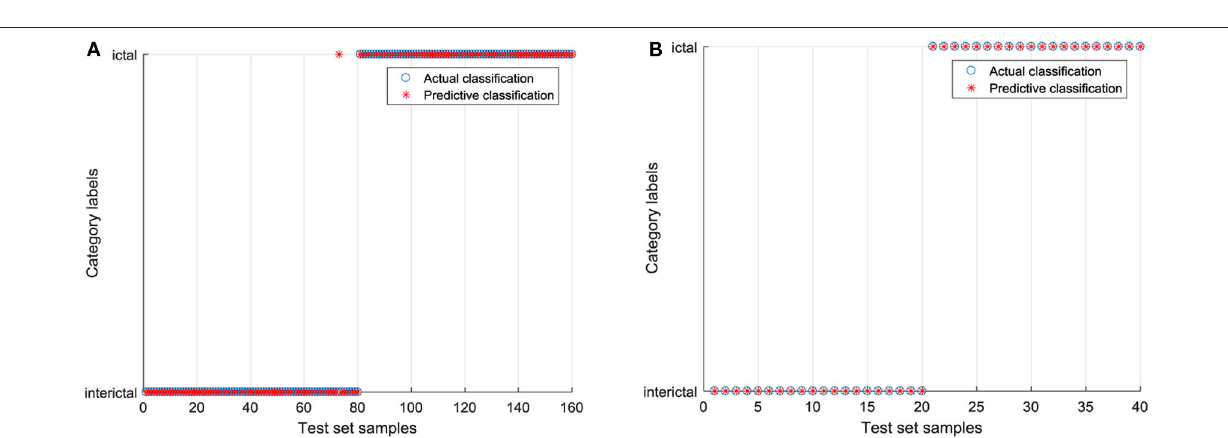
FIGURE 7 | The classification results of the raw EEG signals by SVC. (A) Classification diagram of training set and (B) Classification diagram of test set.